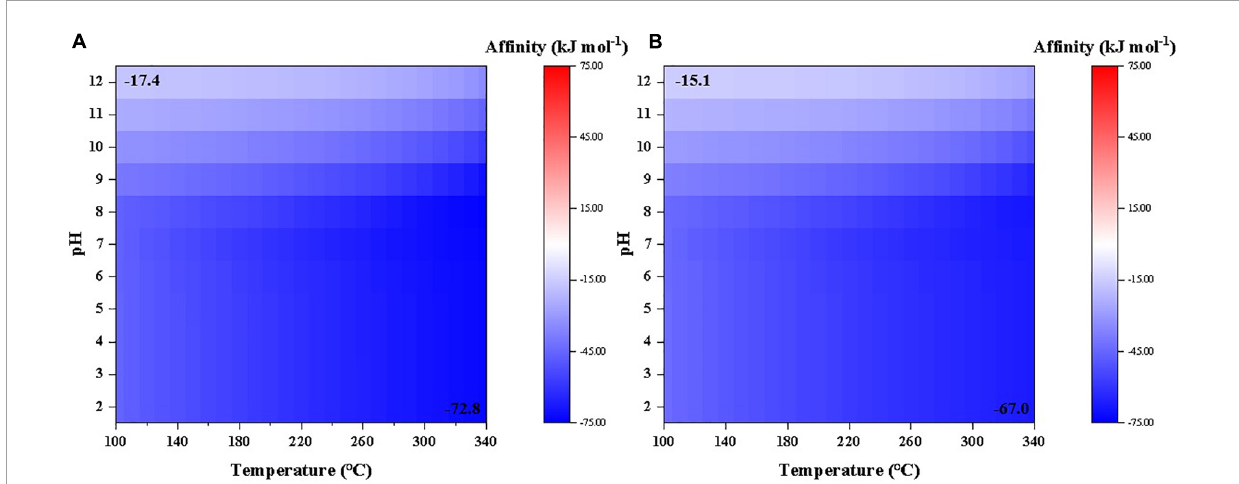
FIGURE1 Synthesis affinity of cyanide (HCN, aq + CN - ) using (A) CO, g and (B) CO 2 , g as the carbon source.